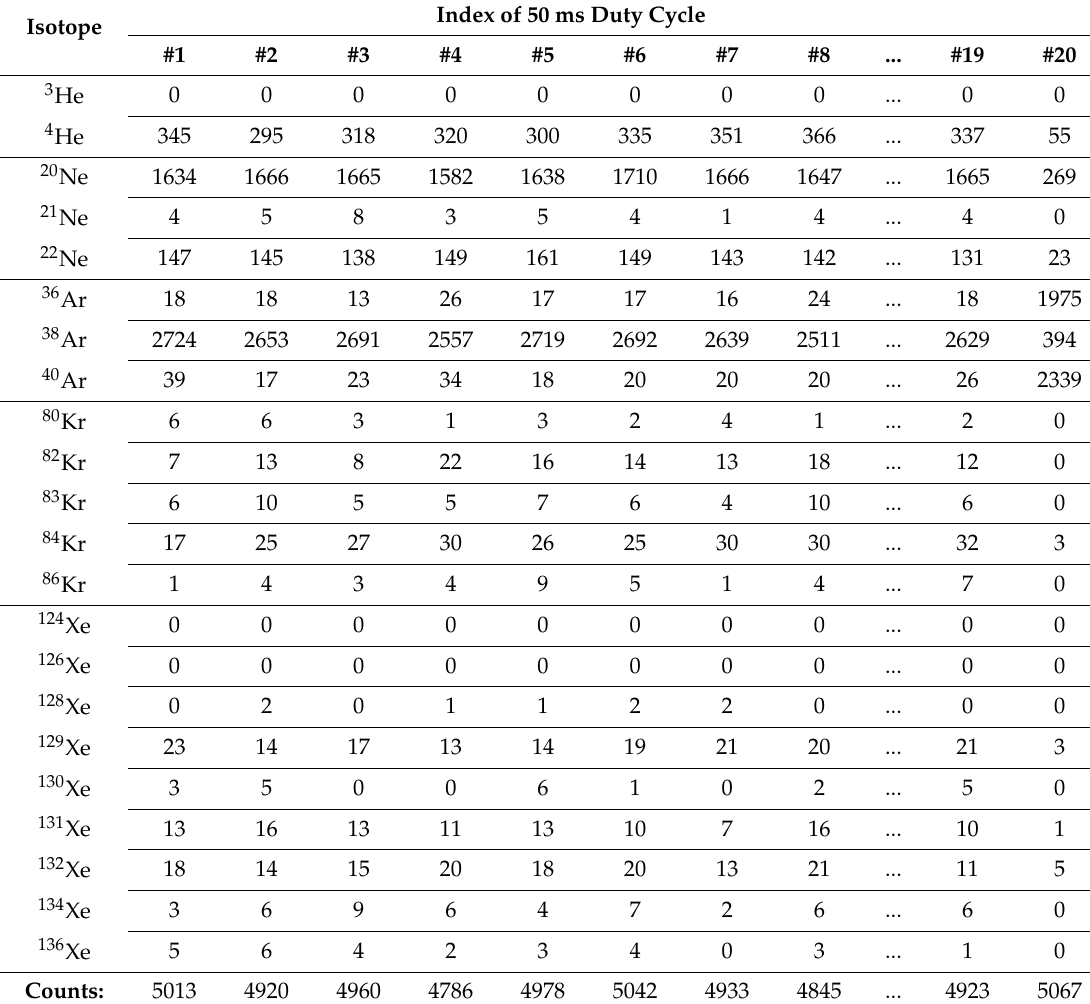
Table 8. The distribution of number of randomly created ions during 20 subsequent 50 ms duty